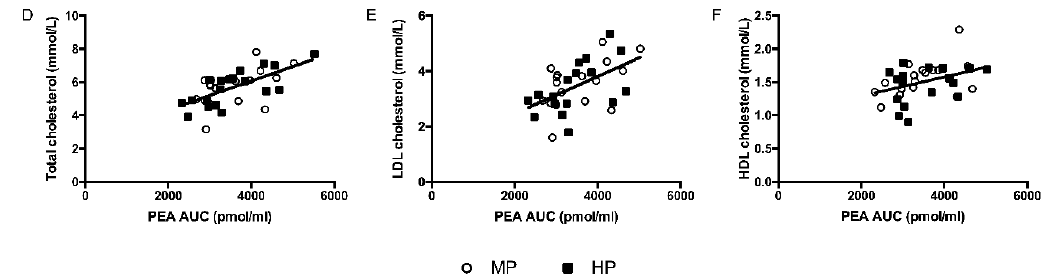
Figure 1. Association between OEA AUC with ( A ) daily heart rate (r = 0.373, p = 0.030), ( B ) baseline total cholesterol (r = 0.509, p = 0.002), ( C ) LDL cholesterol (r = 0.444, p = 0.010), and between PEA AUC with ( D ) total cholesterol (r = 0.594, p = 0.001), ( E ) LDL cholesterol (r = 0.527, p = 0.002), and ( F )